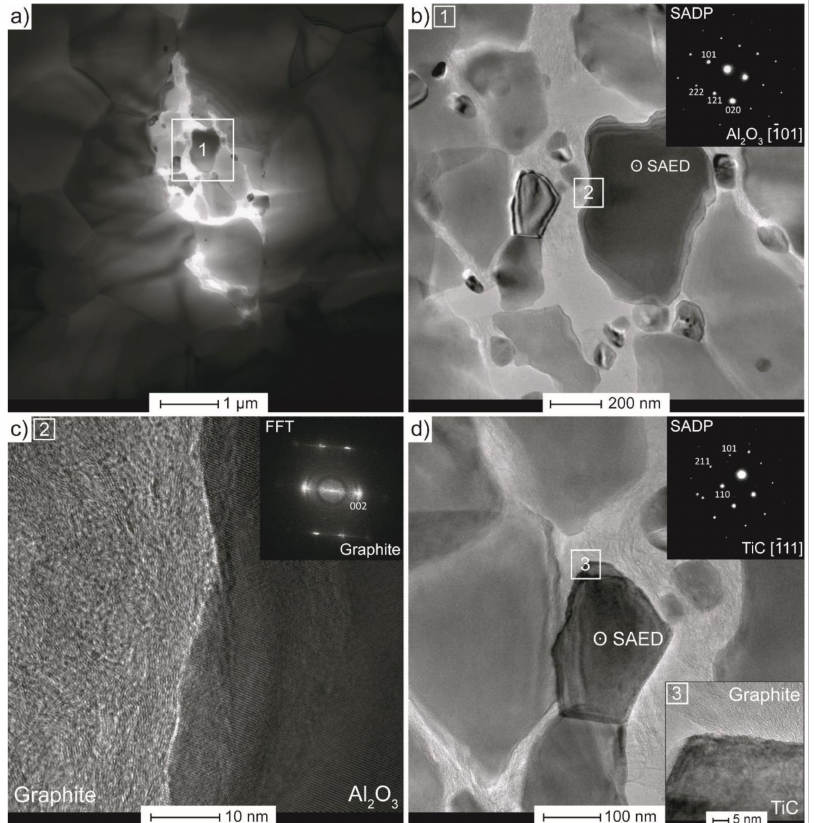
Figure 10. Transmission electron microscopy (TEM) analysis of Al 2 O 3 with 2 wt.% of Ti 3 C 2 : ( a ) microstructure in bright field (BF) mode, ( b ) magnified image from porous area with selected area diffraction pattern (SADP), ( c ) high-resolution TEM (HRTEM) image with Fast Fourier transform (FFT) pattern, ( d ) second phase with SADP and HRTEM image showing its grain